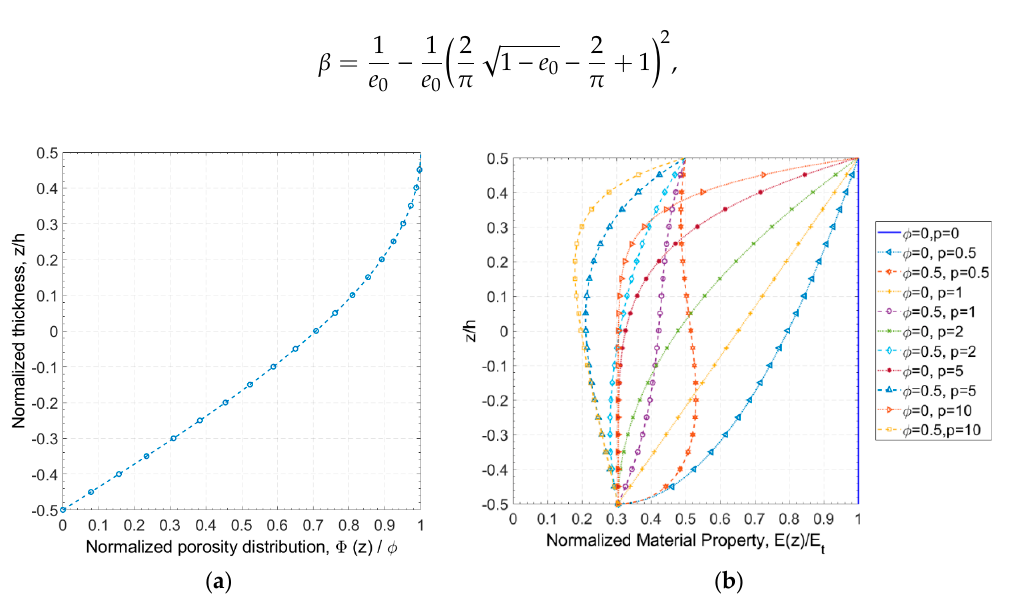
Figure 3. Normalized: ( a ) porosity model M1 and ( b ) Young’s modulus (E(z)) through the thickness direction.